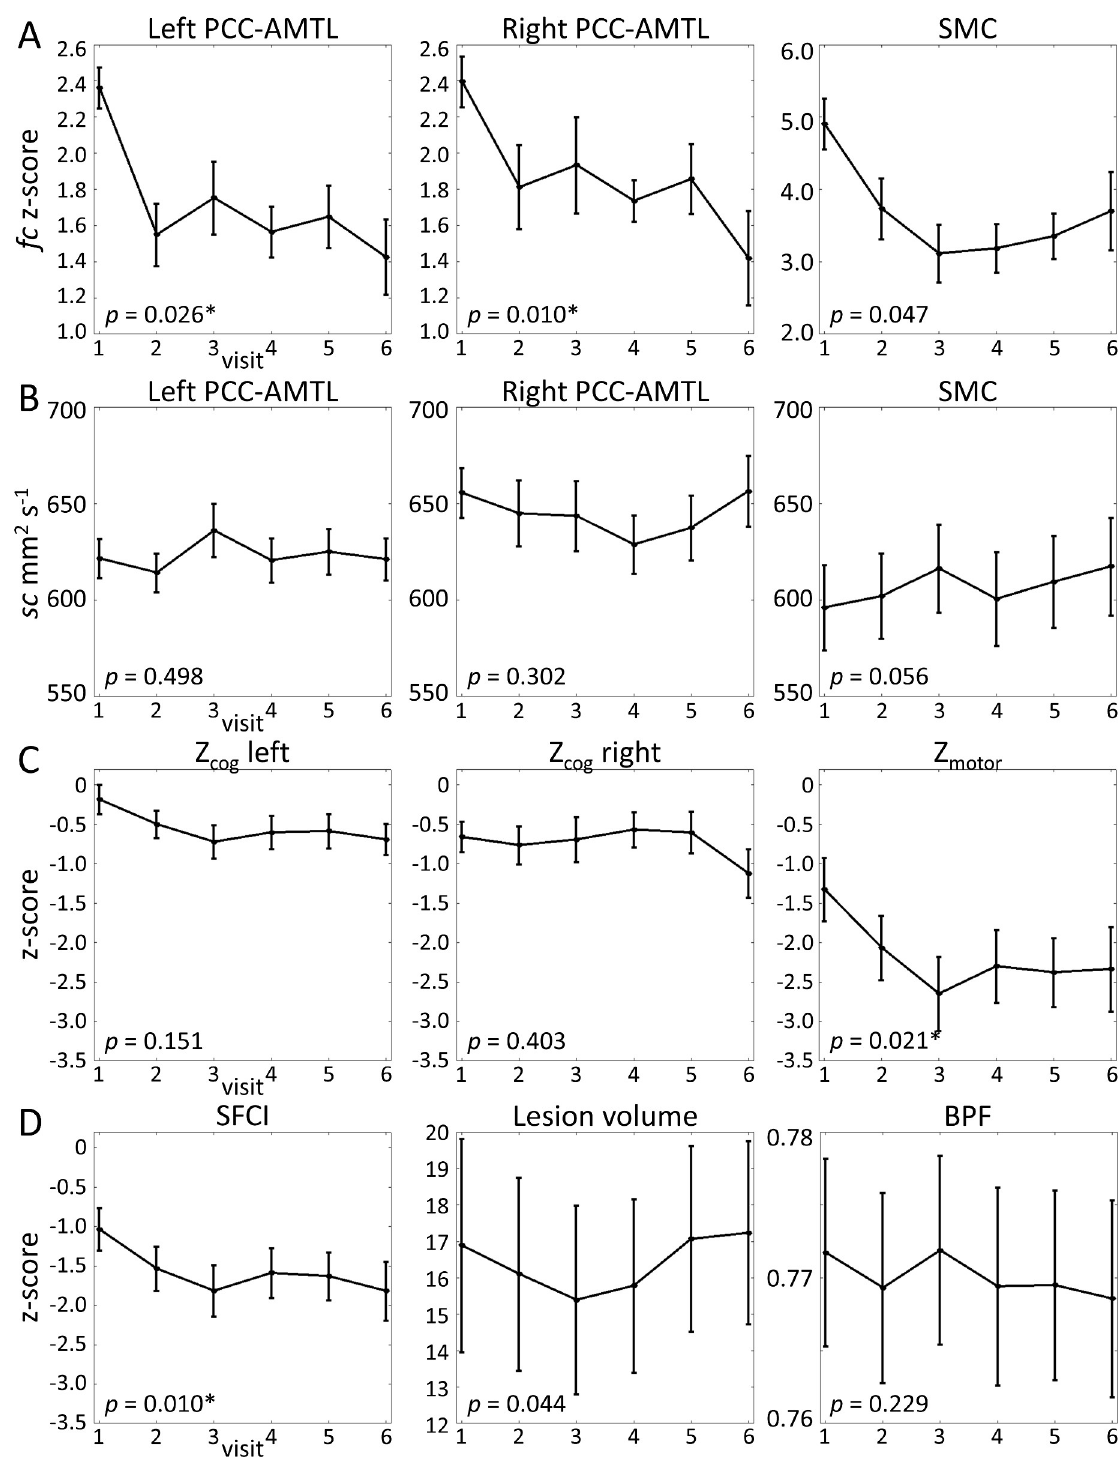
Fig 6. Averaged imaging measures in participants with MS as a function of visit. Error bars represent standard error. LRT p -values are included in each plot. A. rsfMRI ( fc ), B. DTI ( sc ), C. SFCI components, and D. SFCI in the tracks of interest. E. Whole-brain imaging measures. � denotes significant result. BPF = brain parenchymal fraction; see Table 3 for additional abbreviations.